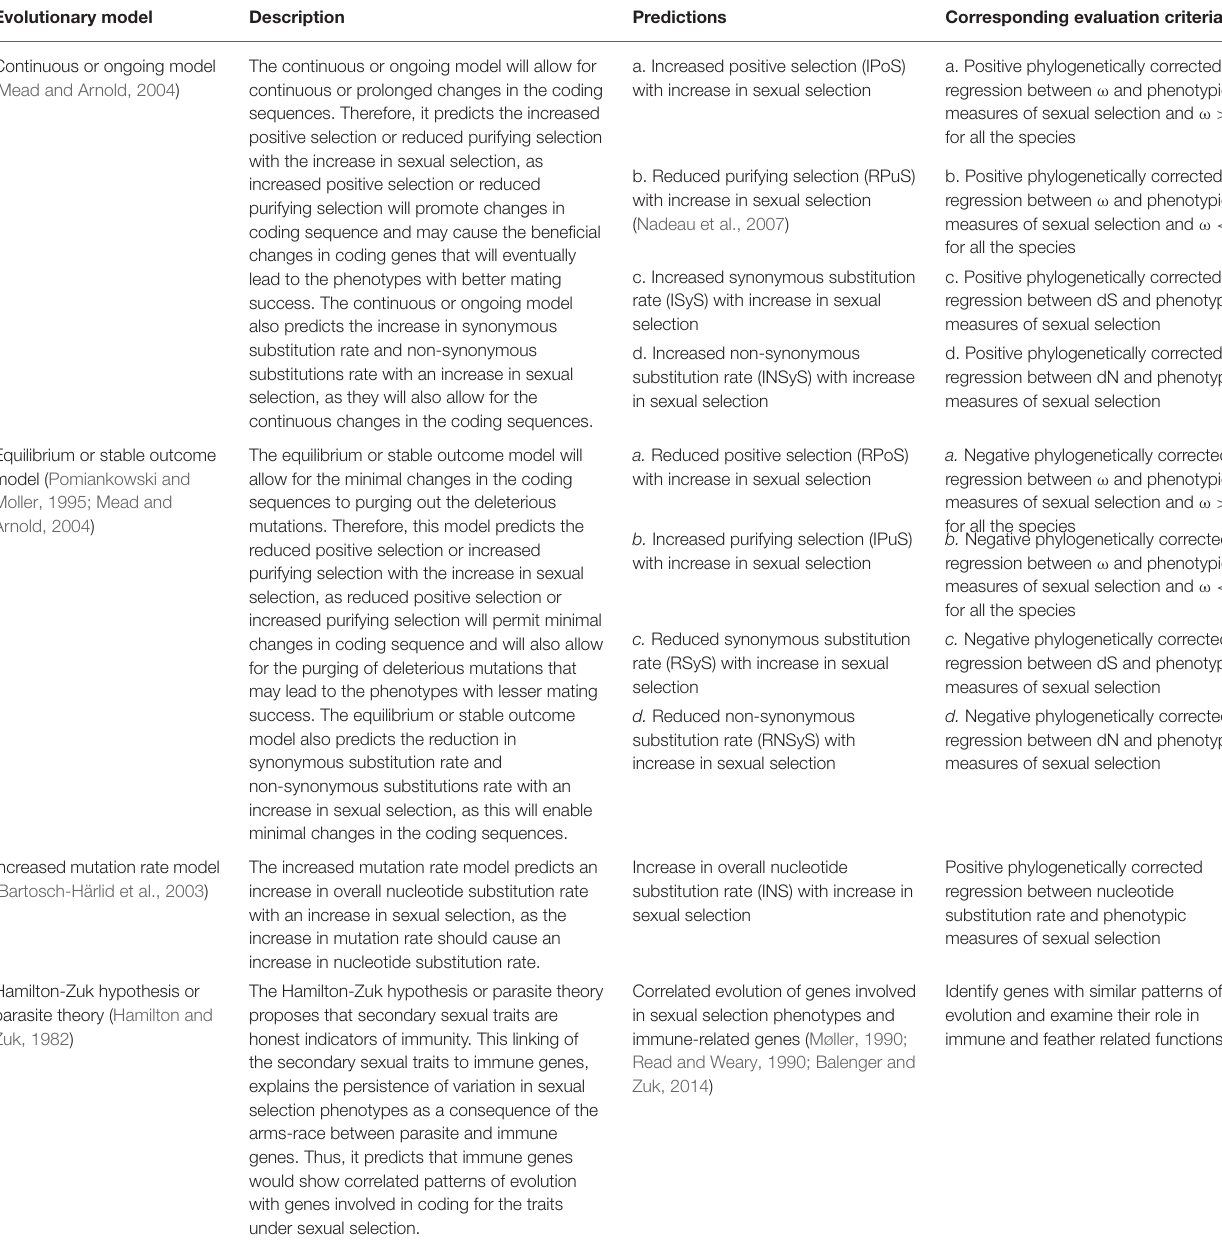
TABLE 1 | Description of evolutionary models of sexual selection along with their predictions about the molecular evolutionary parameters, and the corresponding criteria to evaluate the predictions. Evolutionary model Description Predictions Corresponding evaluation criteria Continuous or ongoing model (Mead and Arnold,